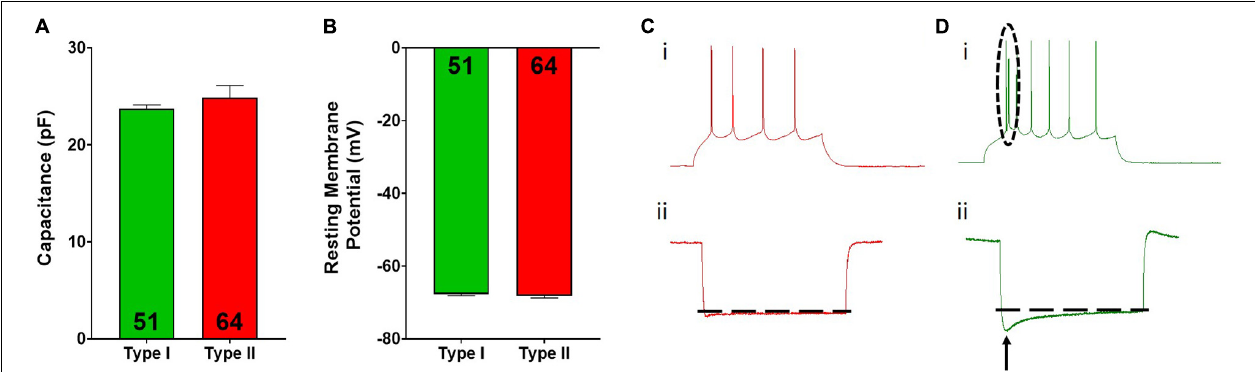
FIGURE 2 | Type I and type II pyramidal cell electrophysiological characteristics. Type I (green) and type II (red) cells do not differ in cellular capacitance (A) or resting membrane potential (B) . Representative spiking for type II (Ci) and type I (Di) cells is shown. The dotted circle in Di highlights the spiking doublet elicited in type I cells. Representative hyperpolarization traces for type II (Cii) and type I (Dii) cells are shown, where type I cells display a large “sag” indicated by the arrow. Inset numbers in (A,B) represent the number of cells analyzed.